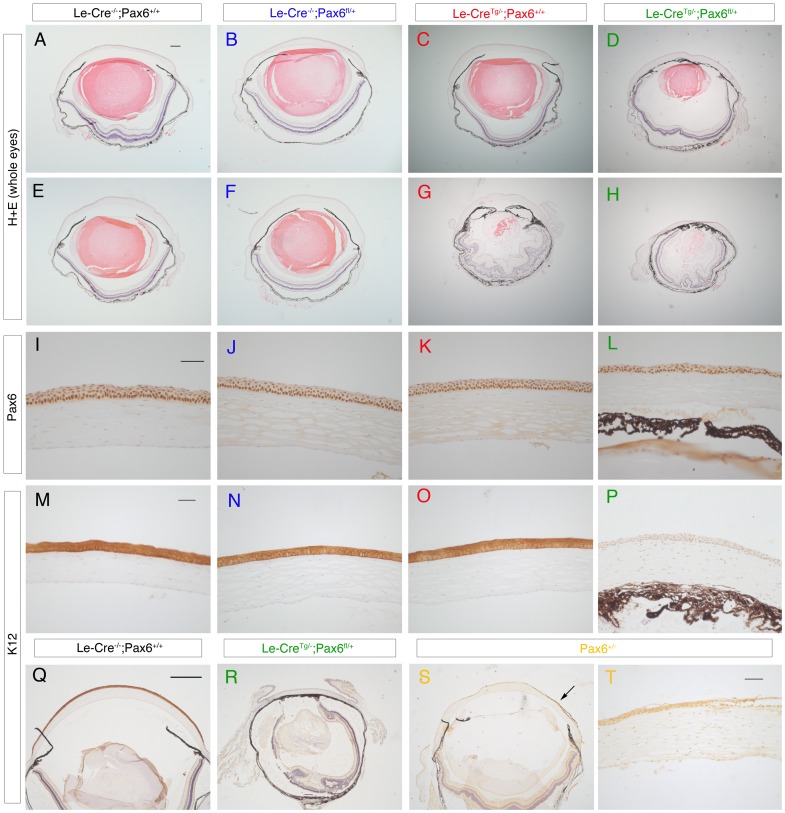
Morphology of eyes and corneal immunostaining for Pax6 and K12 from adults in stage 3.(A–H) H & E stained sections of adult eyes from stage-3 crosses (with a predominantly CBA/Ca genetic background) showing normal morphology of (A,E) Le-Cre−/−; Pax6+/+, (B,F) Le-Cre−/−; Pax6fl/+ and (C) an Le-CreTg/−; Pax6+/+ control eye but abnormal morphology of (G) another Le-CreTg/−; Pax6+/+ control eye and a range of morphological abnormalities in (D,H) experimental Le-CreTg/−; Pax6fl/+eyes. (I–L) Pax6 immunostaining (brown endpoint) in the corneal epithelium of all four genotypes. (M–P) K12 immunostaining (brown endpoint) in the central corneal epithelium shows K12 is present in the corneal epithelium of all three control eyes but absent from the Le-CreTg/−; Pax6fl/+ corneal epithelium. (Q–S) Low power views of K12 immunostaining (brown endpoint) across the whole corneal epithelium showing (Q) strong staining in an Le-Cre−/−; Pax6+/+control eye, (R) no staining in an Le-CreTg/−; Pax6fl/+ eye and (S) weak and patchy staining in a heterozygous Pax6+/Sey-Neu eye (arrow shows a K12-positive region). (T) Higher power view of a K12-positive region in the corneal epithelium of an adult Pax6+/Sey-Neu heterozygote. Scale bars: A–P (shown in the first panel of each row) and T = 200 µm, Q–S (shown in Q)  = 500 µm.